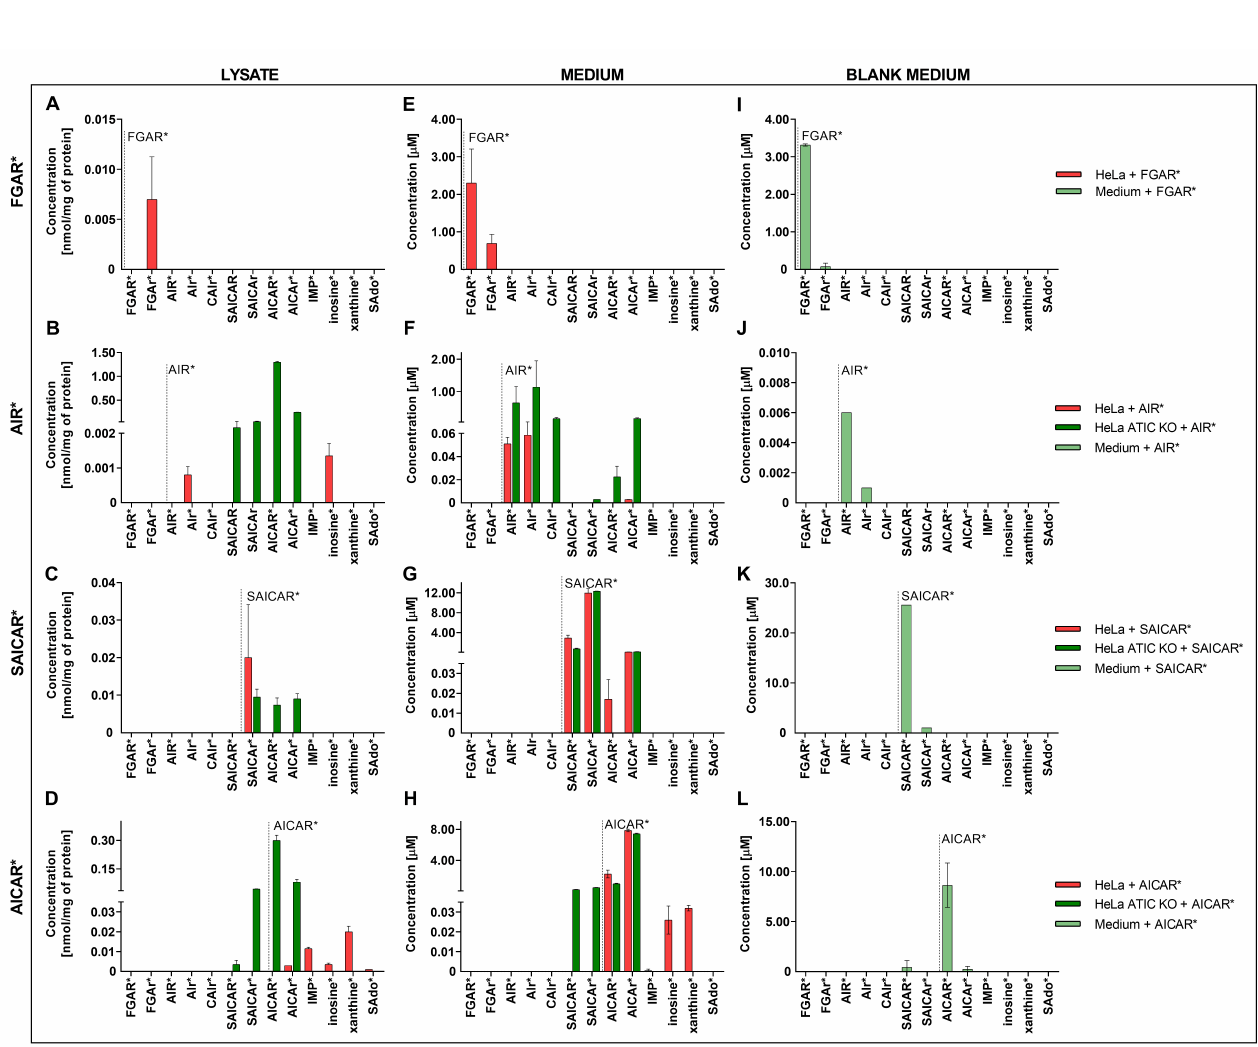
Figure 2. Accumulation of isotopically labeled DNPS metabolites (FGAR*, AIR*, SAICAR*, AICAR*). Vertical dashed line indicates which DNPS metabolite was added. The graphs ( A – D ) represent the concentration of detected isotopically labeled metabolites in HeLa control cell lysate after the addition of FGAR*, AIR*, SAICAR*, and AICAR* (red), and in ATIC KO cell lysate after addition of FGAR*, AIR*, SAICAR*, and AICAR*(dark green). The graphs ( E – H ) represent the concentration of detected isotopically labeled metabolites in HeLa control cell growth medium after the addition of FGAR*, AIR*, SAICAR*, and AICAR* (red), and in ATIC KO cell growth medium after addition of FGAR*, AIR*, SAICAR*, and AICAR* (dark green). The graphs ( I – L ) display results for detected labeled metabolites in blank medium (medium without cells) after addition of FGAR*, AIR*, SAICAR*, and AICAR* (light green). The results for untreated cells were zero or approaching zero, and are not shown in the graph. Each data point represents the mean of a single experiment measured in duplicate. Vertical bars represent S.D. (n = 2). List of all measured isotopically labeled metabolites is shown in Table